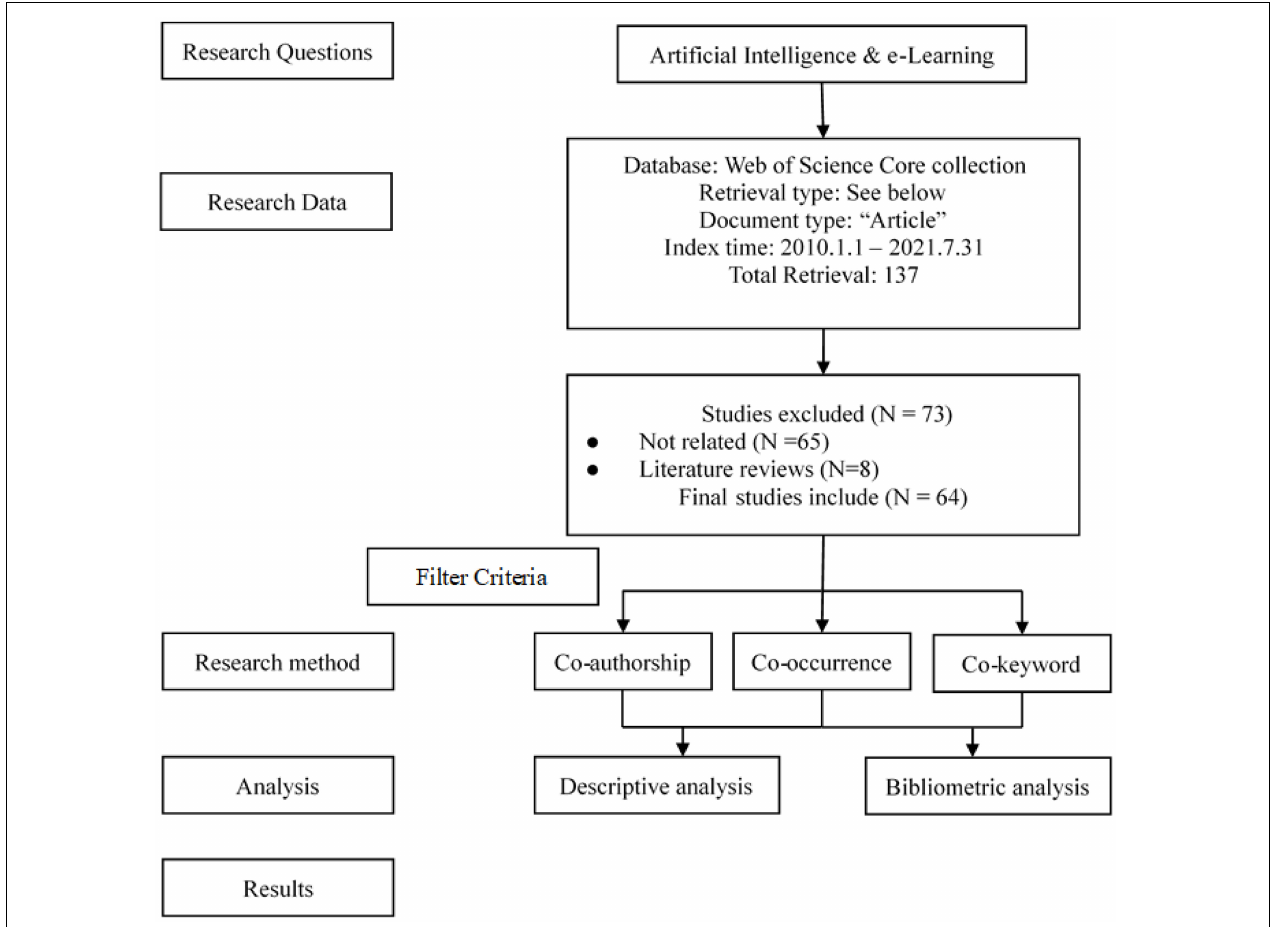
FIGURE 1 | Article selection process for bibliometric mapping analysis.